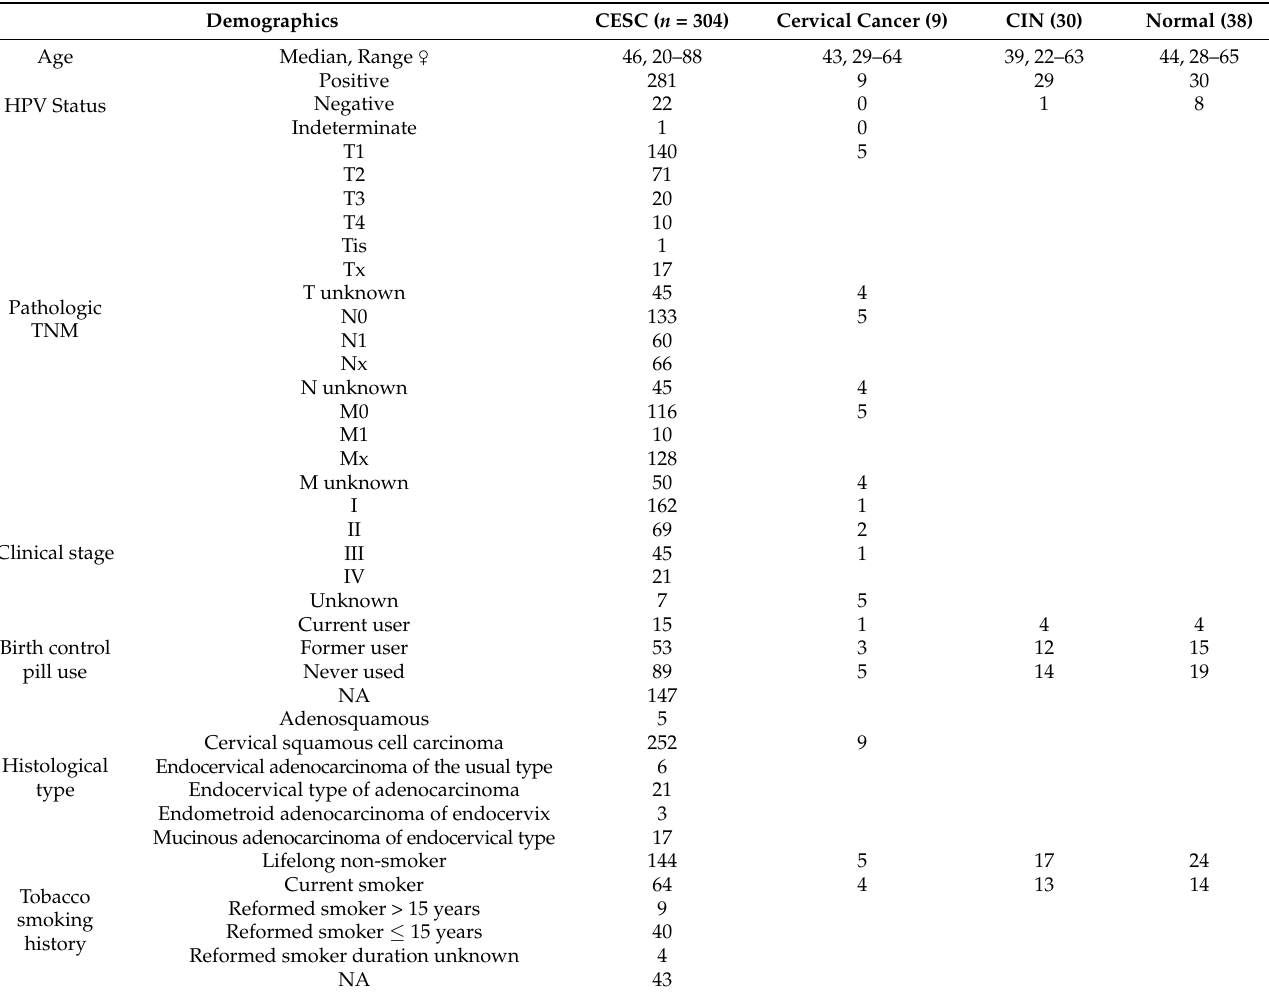
Table 3. Clinical data of patients used in the analysis of The Cancer Genome Atlas TCGA data, as well as in the analysis of validation